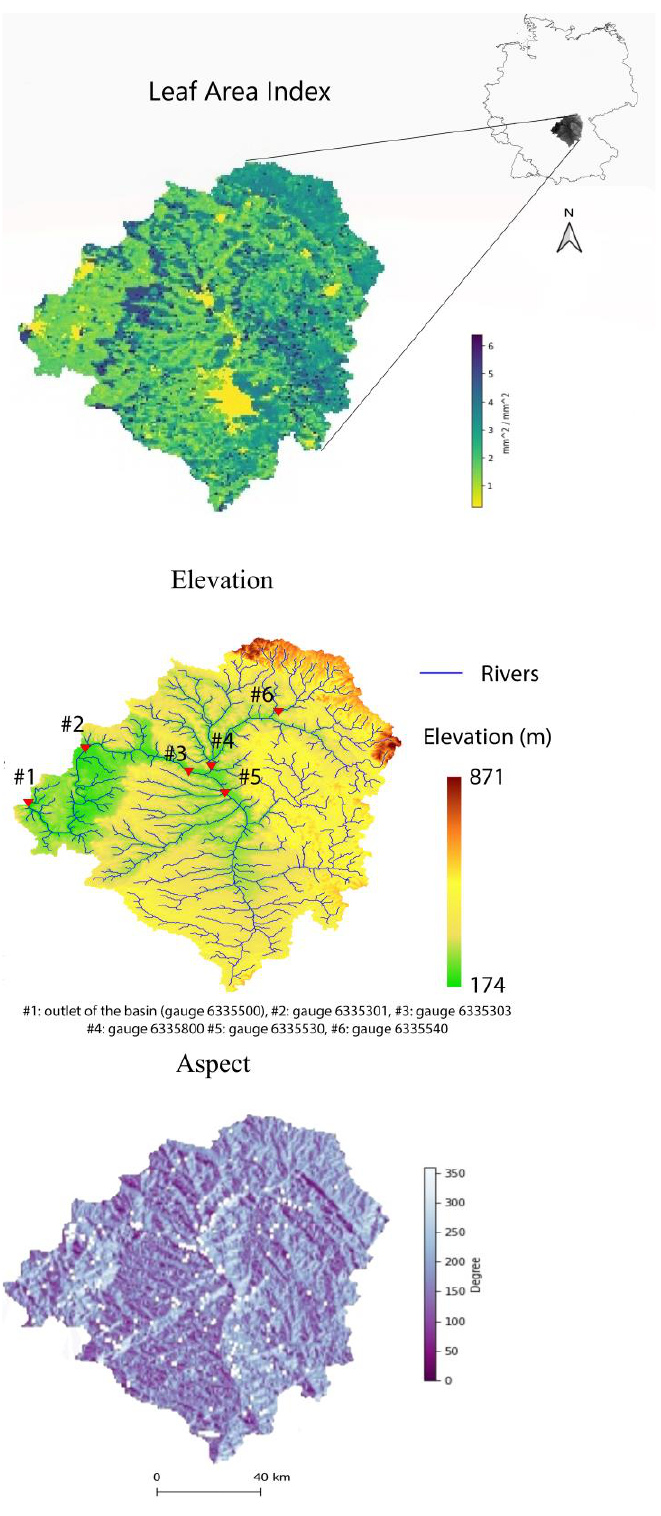
Figure 1. Physical characteristics (LAI, DEM, and aspect maps) of the study domain, i.e., the Main Basin in Germany and streamflow gauge locations on the tributaries .